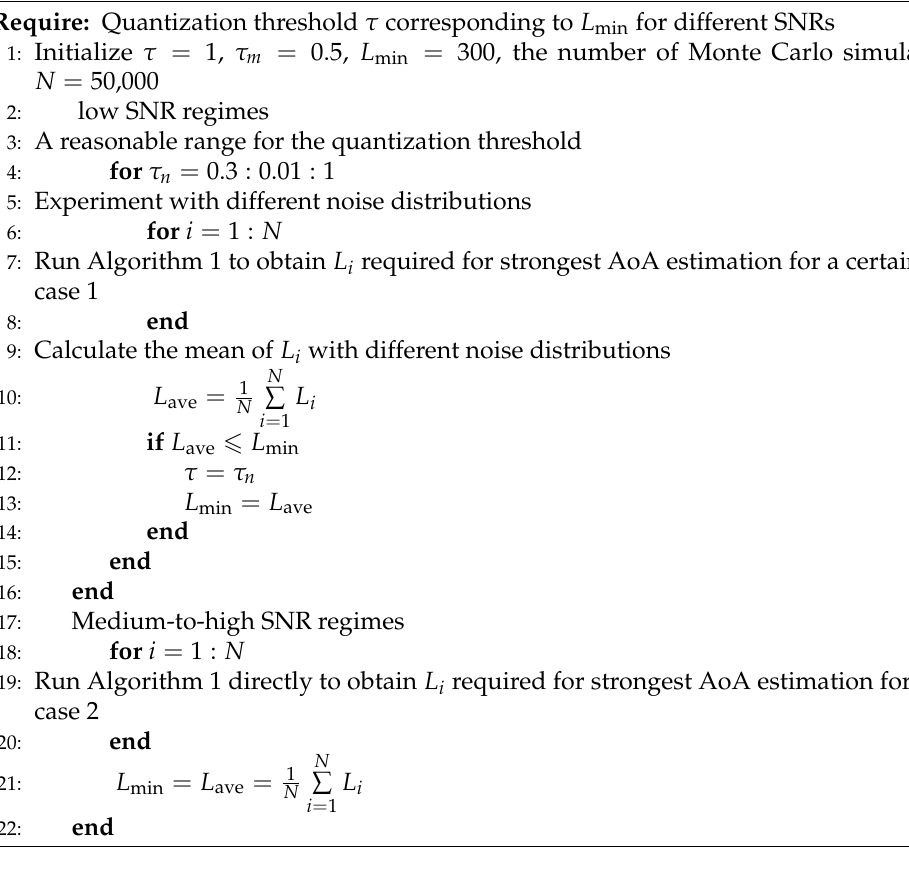
Algorithm 2 Monte Carlo Simulation for L